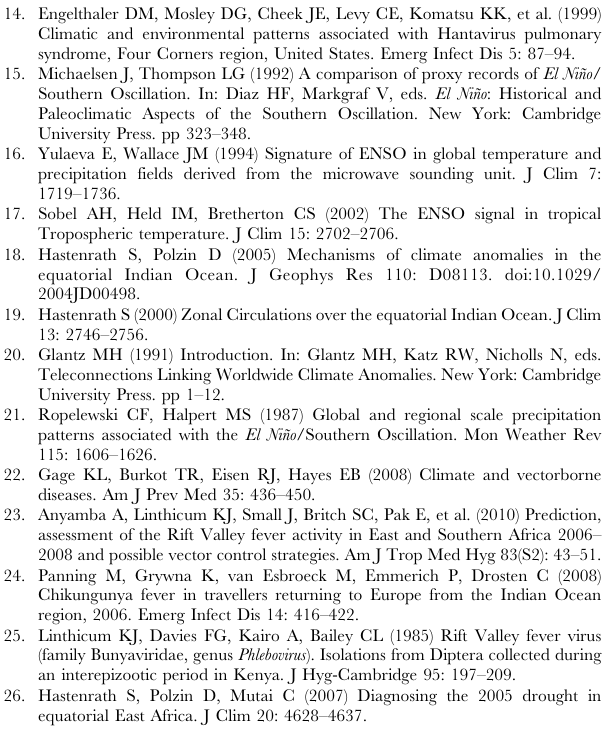
Figure S3 Cumulative daily rainfall profiles for periods of Rift Valley fever activity for selected outbreak sites. Cumulative daily rainfall (green lines) profiles for periods of Rift Valley fever activity and mean long-term cumulative daily rainfall